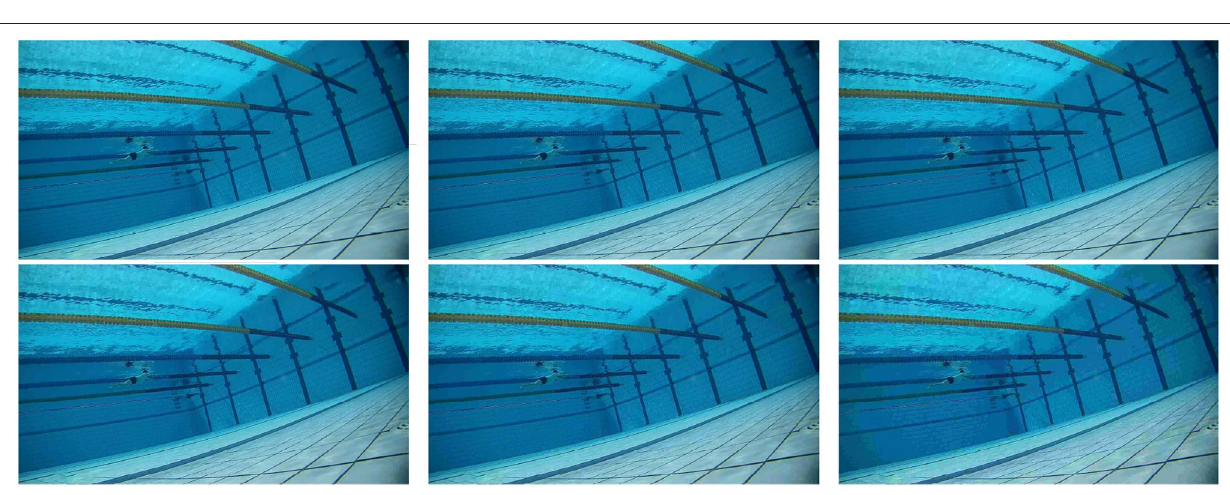
FIGURE 2 | One original image and its five distorted images vary from 10 to